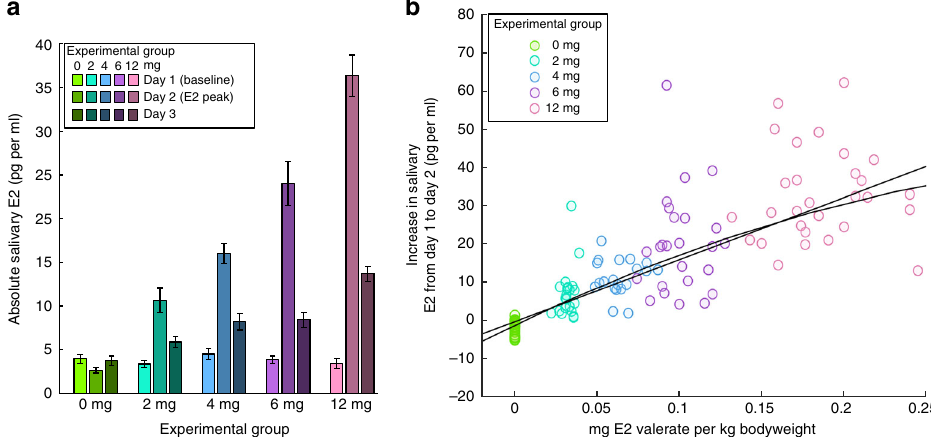
Fig. 2 17-beta-estradiol (E2) levels in saliva of the experimental groups ( N = 125). a Absolute levels. Error bars represent standard errors of the mean. Con fi rming the effectiveness of the pharmacological manipulation, the increases in salivary and serum E2 levels from baseline (Day 1) to the expected peak (Day 2) differed as intended between experimental groups (saliva: F (4, 47.98) = 102.84, p < .001; serum: F (4,31.24) = 87.54, p < .001; see Supplementary Note 2 for tests of variance homogeneity). b Robust linear regression analyses between dose of E2 valerate given per kg bodyweight and salivary E2 increase ( p < .001). A low Bayesian Information Criterion difference score ( Δ BIC; linear — quadratic model) of − 1.36 suggests that the linear and quadratic model fi t equally well. Colors represent experimental groups